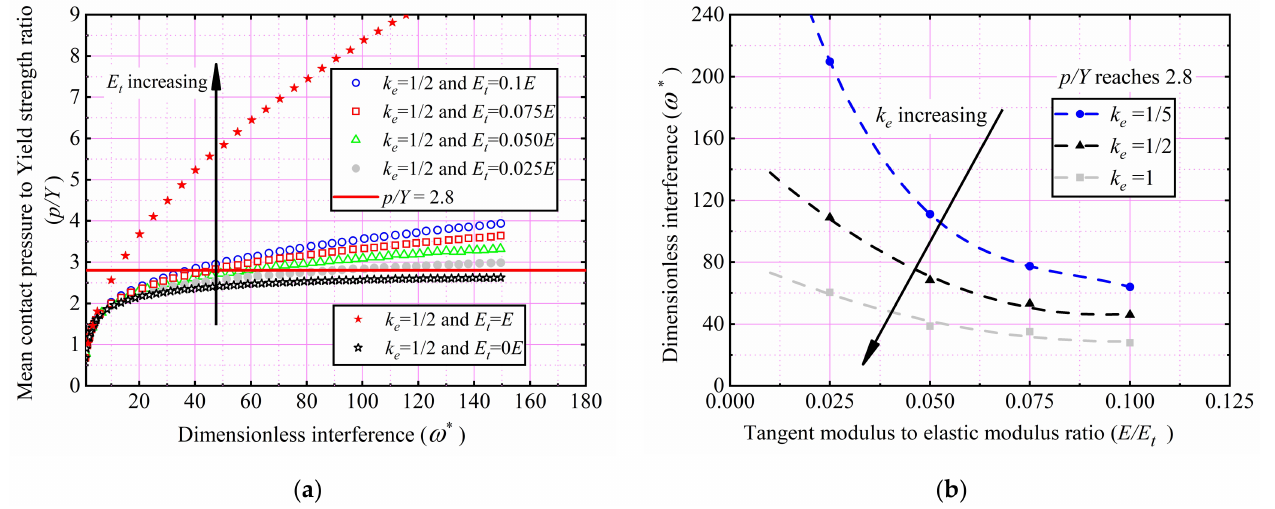
Figure 8. ( a ) Evolution of p/Y with increasing ω * under different E t values at k e = 1/2. ( b )